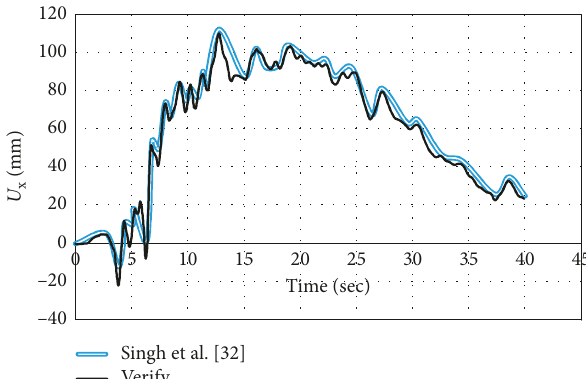
Figure 3: Verification time-history analysis with the result of Singh et al. [32] for horizontal displacement of the tunnel crown.